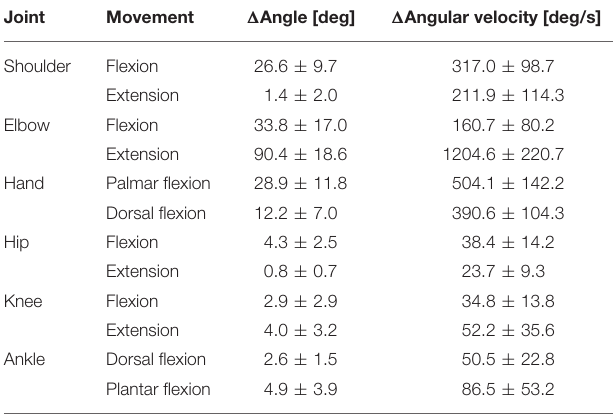
TABLE 2 | Kinematic information during the dart